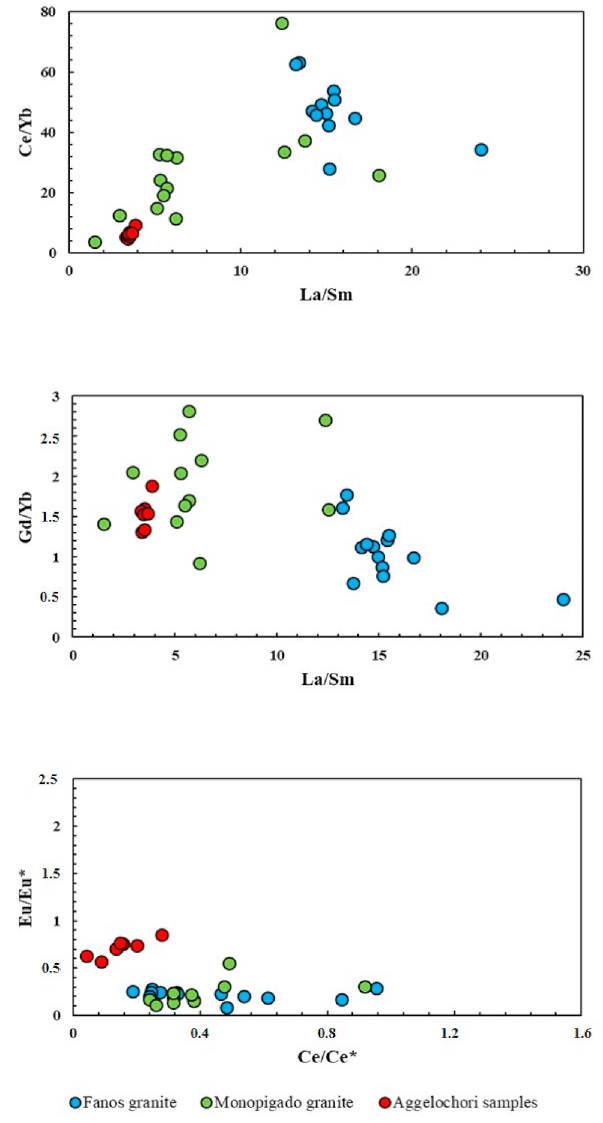
Figure 11. Ce/Yb vs La/Sm, Gd/Yb vs La/Sm and Eu/Eu*/Ce/Ce* for the samples from Aggelo- chori, Monopigado and Fanos granitic rocks. Symbols for the studied samples as in Figure 5. It is evident (Figure 11) that there is a resemblance between the Aggelochori samples and the granitic samples from Monopigado pluton, especially as far as Ce/Yb vs La/Sm, Gd/Yb vs La/Sm are